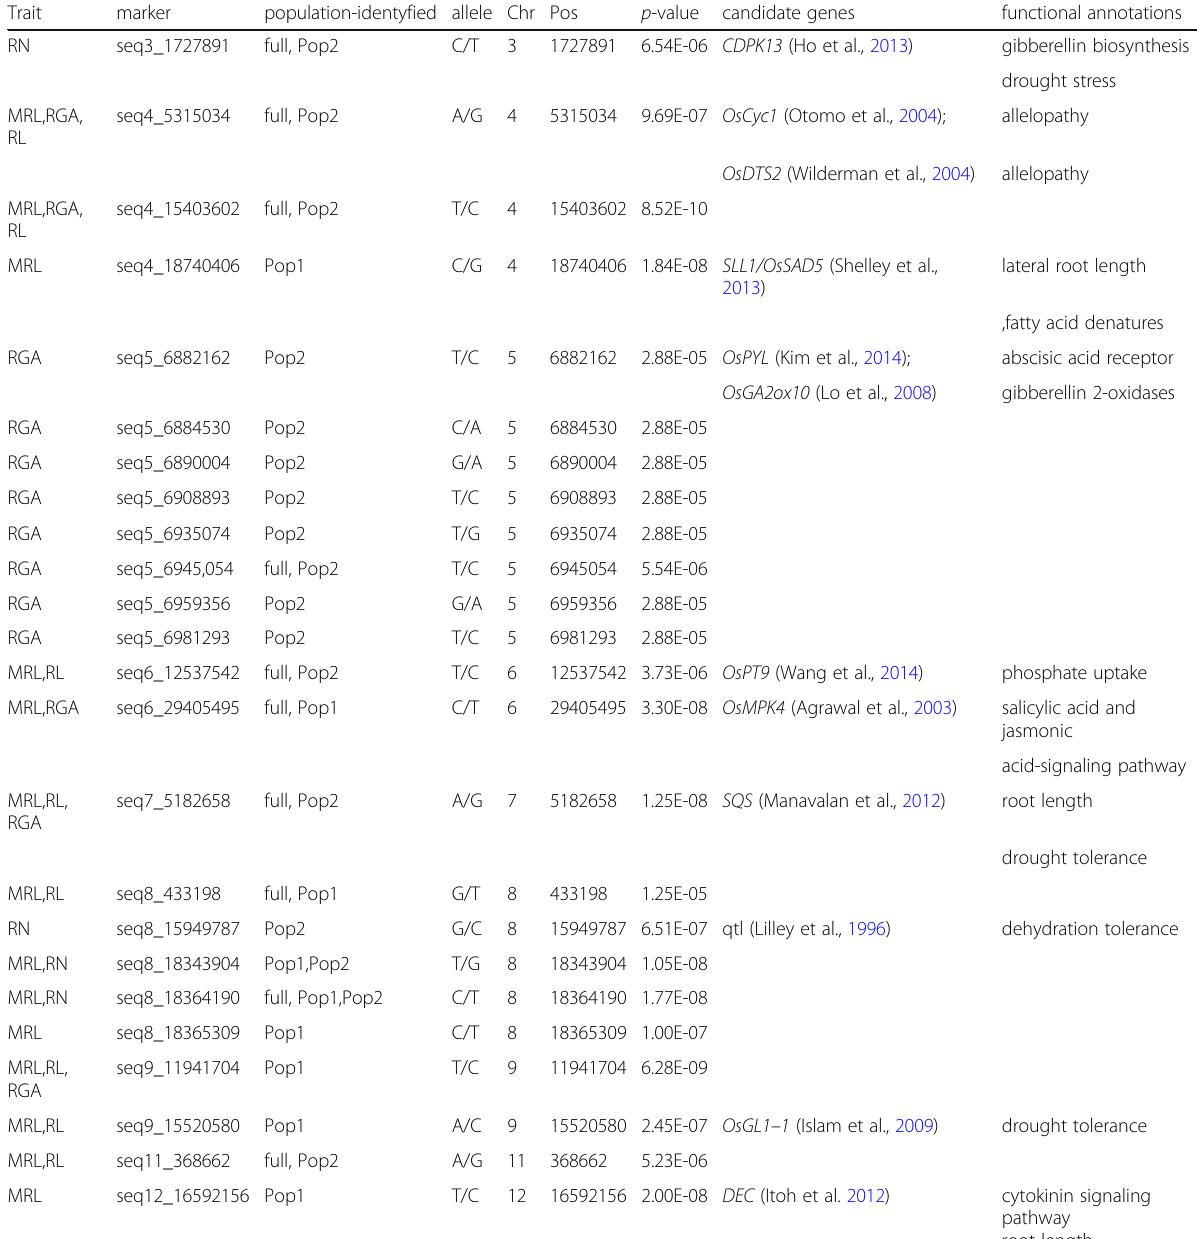
Table 2 The 24 significant SNPs and their rice genomic information